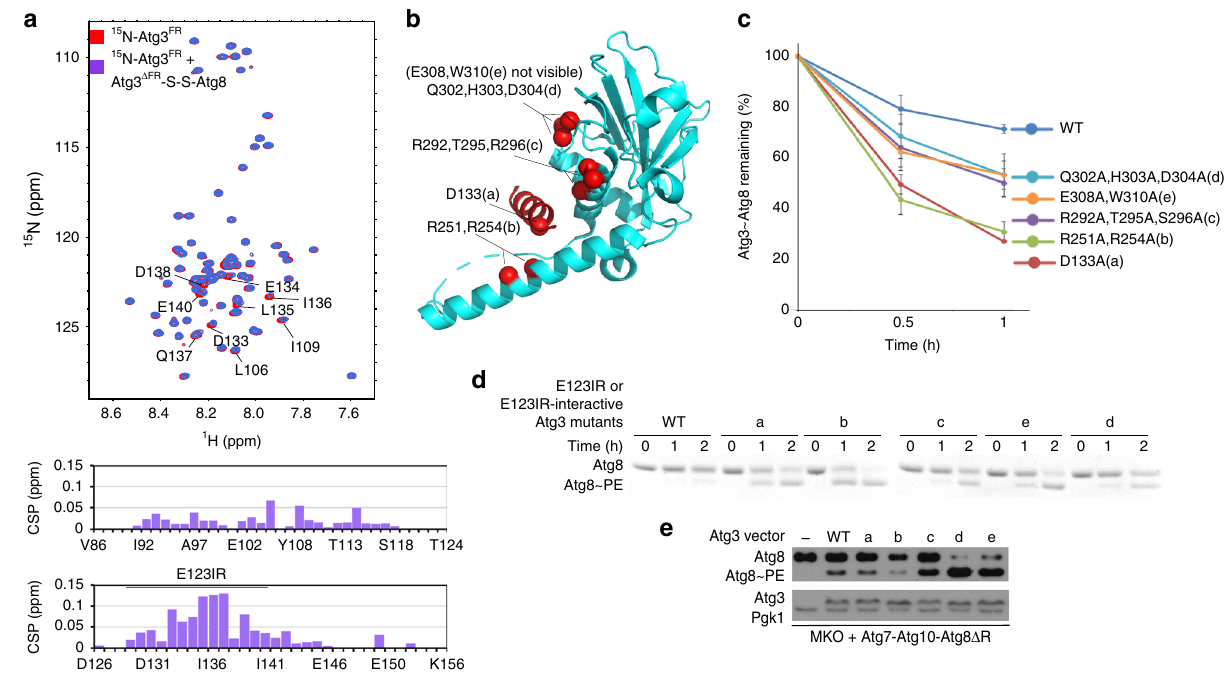
Fig. 6 Mutations in E123IR-binding residues activate Atg3~Atg8 in the absence of E3 in vitro and in vivo. a [ 15 N, 1 H] TROSY spectra of 15 N-labeled Atg3 FR alone (red) or in 1:2 mixture with unlabeled, disul fi de-bonded proxy for Atg3 Δ FR – Atg8 (purple), with chemical shift perturbations (CSPs) per residue shown below. b Locations of mutations a – e designed to impair interactions between Atg3 ′ s catalytic domain and E123IR shown on crystal structure of Atg3 (PDB 2DYT). c Effects of indicated mutants in Atg3 catalytic domain-E123IR interface on intrinsic E3-independent activity of Atg3~Atg8 intermediate. Quanti fi cation is of WT or indicated mutant versions of Atg3~Atg8 remaining after 2.5 min as a function of NH 2 OH concentration in pulse-chase assays, without E3, repeated 3 times repeats average (Error bar: STDEV, N = 3). Representative gel is shown in Supplemental Fig. 5; all data points are shown in Source Data fi le. d Effects of indicated mutants in Atg3 catalytic domain-E123IR interface on E3-independent Atg8 lipidation in vitro, in reactions with Atg7, Atg12 – Atg5-Atg16, and liposomes generated from E. coli polar lipids as a source PE, and detected by migration of Atg8 in Coommassie-stained SDS-PAGE gel. e Effects of indicated mutants in Atg3 catalytic domain-E123IR interface on E3-independent Atg8 lipidation in vivo, as detected by western blot for Atg8 after 4 h starvation of the YCY131 multi-Atg knockout strain of S. cerevisiae expressing Atg7, Atg10, Atg8 Δ R (activated in absence of Atg4) and either WT or mutant HA-tagged